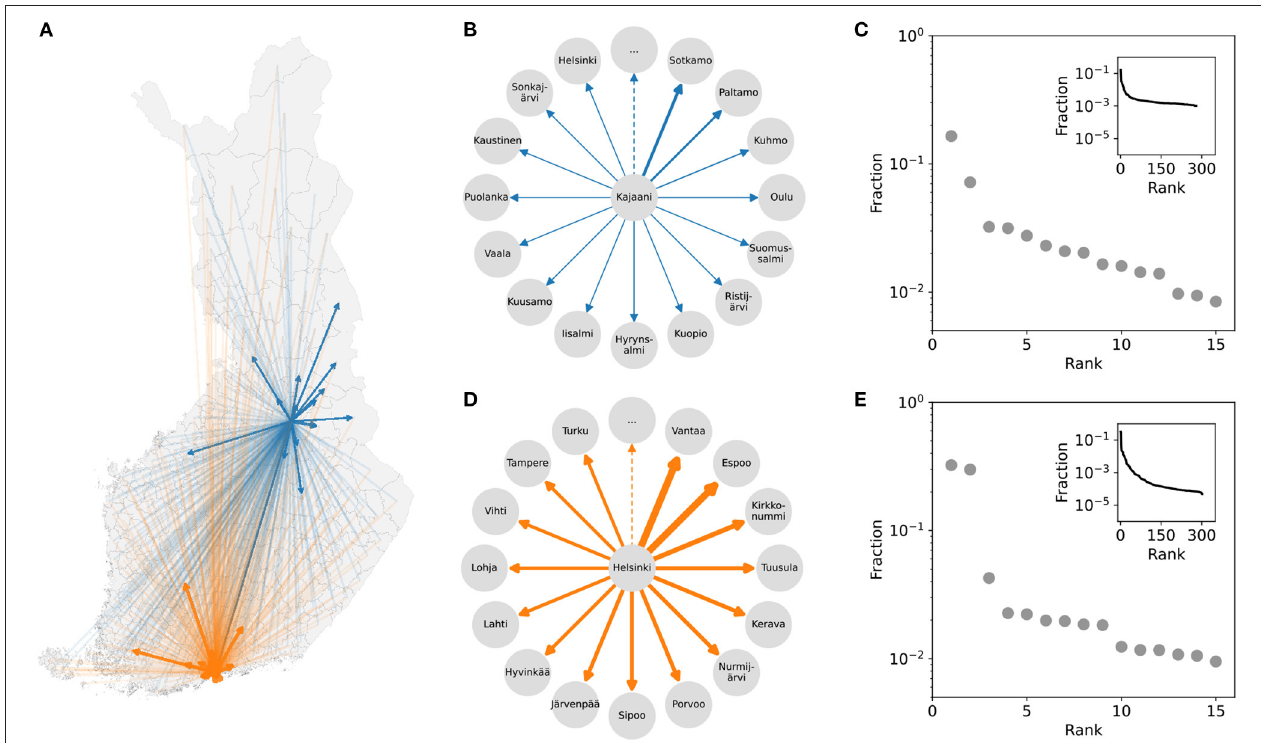
FIGURE 1 | City-centric networks and mobility signatures. A city-centric network studies the network surrounding one particular city/municipality. (A) Outgoing mobility flows for Kajaani (blue) and Helsinki (orange). (B,D) The city-centric networks for Kajaani and Helsinki, respectively. (C,E) The mobility signatures for Kajaani and Helsinki; these signatures are constructed by counting the number of outgoing trips from each municipality to destinations, ranking the destinations based on this number, and then calculating the fraction of mobility flow to the total number of outgoing